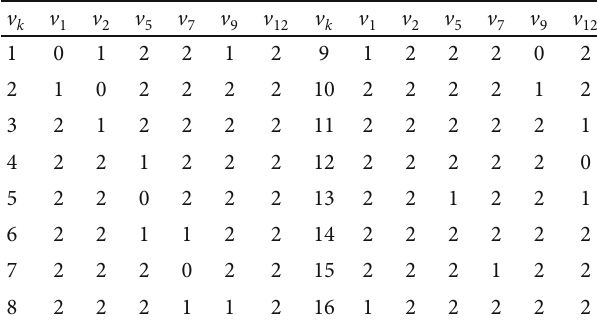
∣ Q Þ of vertices with respect k a